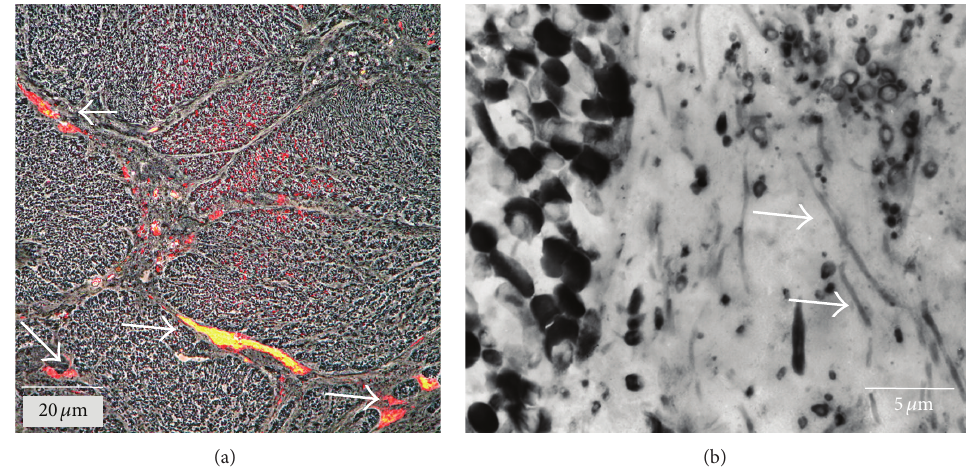
Figure 3: Appearance of gaps between large aggregates. (a) Overview: large patches outside aggregates show intense fluorescence (arrows) after staining with fluorescently labeled ConA lectin. (b) Electron micrograph of a 300 nm thick section from the aggregate periphery with intact cells (left) and cell debris embedded in EPS (right). Arrows point to long filaments.